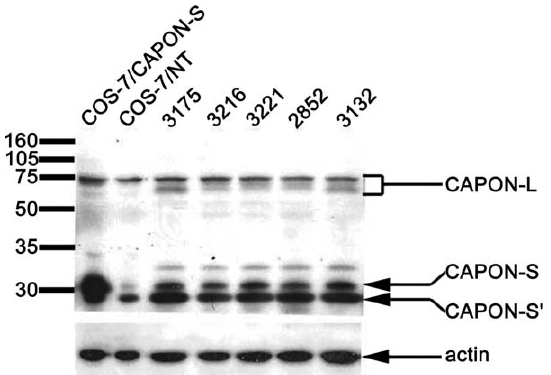
Figure 2. Western Blot of CAPON Protein Isoforms in DLPFC from Normal Control Individuals Tissue from Brodmann’s area 46 (DLPFC) from five individuals was homogenized in TEE. Proteins were resolved by SDS-PAGE and transferred to PVDF membrane. Blots were probed with rabbit polyclonal antibodies to CAPON and actin, and proteins were detected using chemiluminescence. Band intensities for CAPON-L, CAPON-S, and CAPON-S þ CAPON-S 9 were calculated and normalized to the intensities of the corresponding actin bands. Untransfected COS-7 cells expressing CAPON-L and CAPON-S 9 (COS-7/NT) and COS-7 cells expressing recombinant CAPON-S (COS-7/CAPON-S) and were used as controls for these proteins. CAPON-L appears to include multiple bands, possibly due to phosphorylation. DOI: